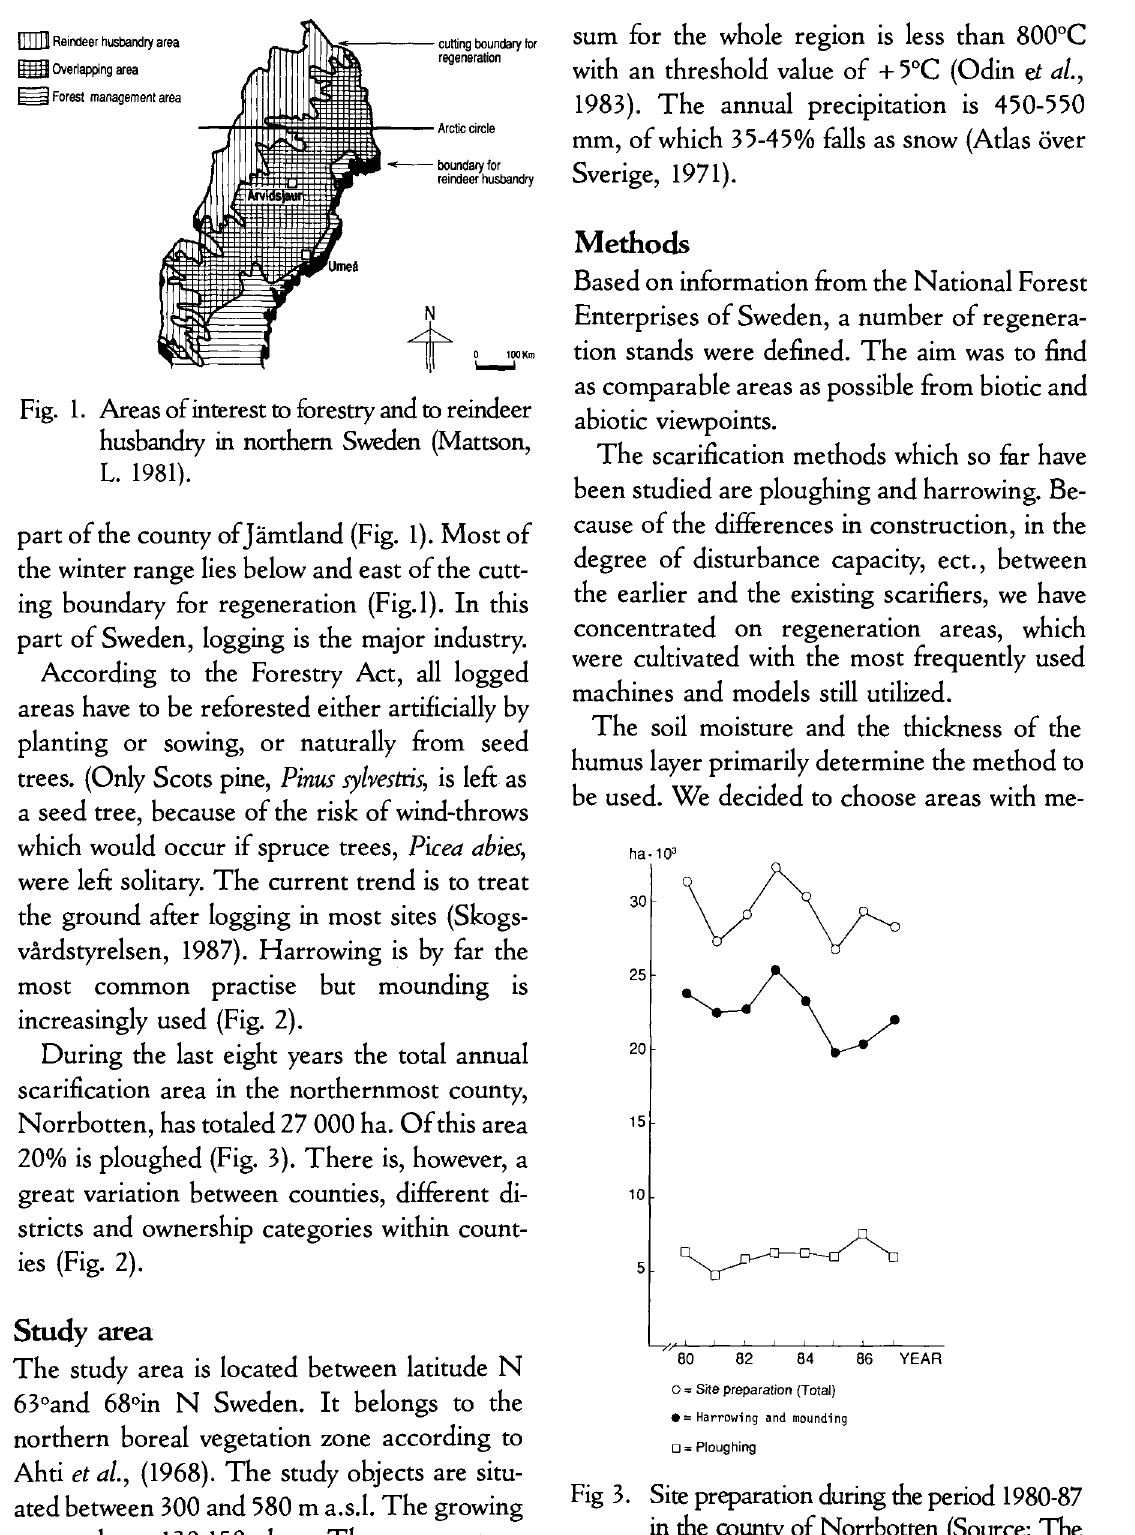
Fig 3. Site preparation during the period 1980-87 in the county of Norrbotten (Source: The National Board of